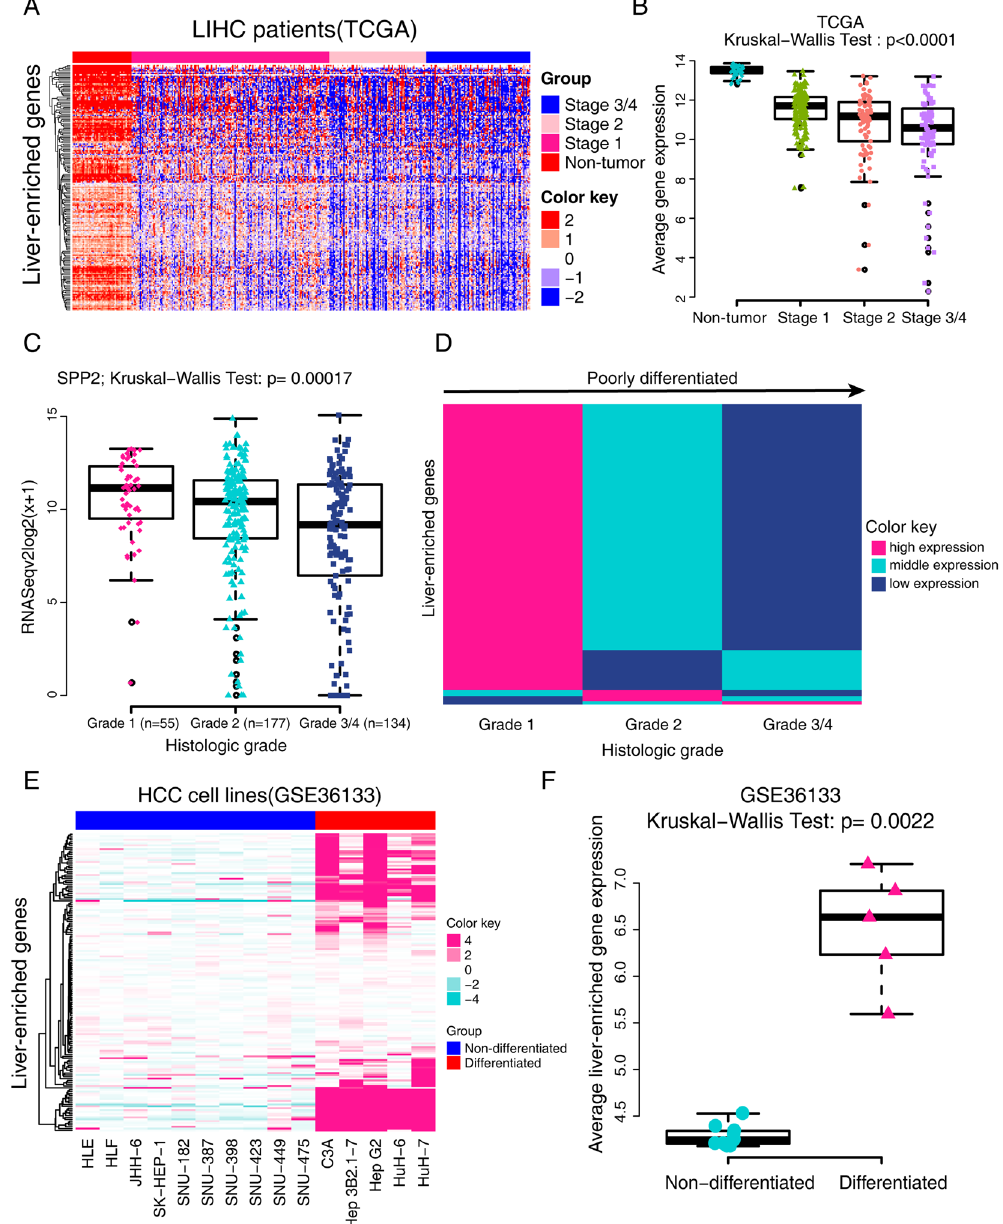
Figure 4. Expression pattern of liver-enriched genes and its relationship with tumor dedifferentiation. ( A ) Heatmap displaying the expression pattern of liver-enriched genes in non-tumor tissues and HCC tissues with different pathological stages in the TCGA dataset. Red indicates high expression and blue indicates low expression. ( B ) Quantitative analysis of the expression pattern of liver-enriched genes in Fig. 4A. RSEM values were Log2 transformed, and the mean values of the liver-enriched genes in every sample were calculated. Then the Kruskal-Wallis test was used to compare differences among the four groups. ( C ) SPP2 was a typical example showing the expression level of liver-enriched genes in different histological grades. SPP2 expression decreased gradually with the progression of the tumor grade. ( D ) Heatmap showing the expression levels of 188 liver-enriched genes in different histological grades. Most liver-enriched genes displayed gradually reduced RNA expression correlated with the augment of tumor grade. ( E ) Comparison of mRNA expression profiles of liver-enriched genes in differentiated and non-differentiated HCC cell lines in GSE36133. Ten were non- differentiated HCC cell lines (HLE, HLF, JHH-6, SK-HEP-1, SNU-182, SNU-387, SNU-398, SNU-423, SNU- 449 and SNU-475) and five were differentiated cell lines (C3A, Hep3B2.1-7, HepG2, HuH-6 and HuH-7). ( F ) Quantitative analysis of the expression pattern of liver-enriched genes in the differentiated and non- differentiated HCC cell